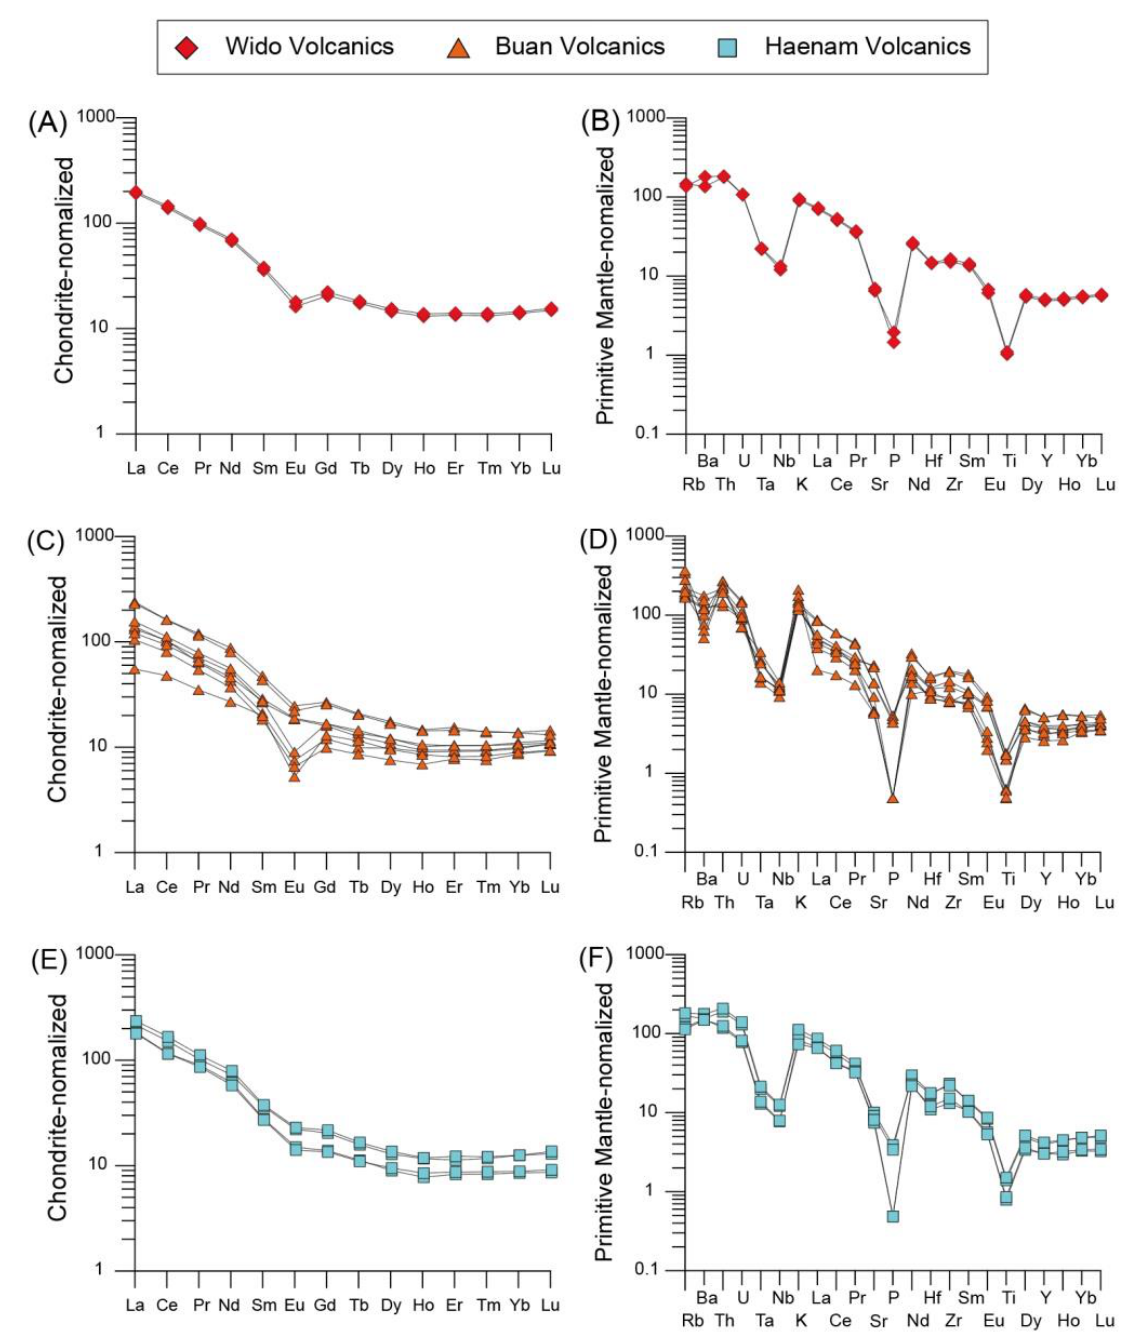
Figure 9. Chondrite-normalized rare earth element and primitive mantle-normalized trace element for the Cretaceous volcanic rocks from the southwestern Korean Peninsula.